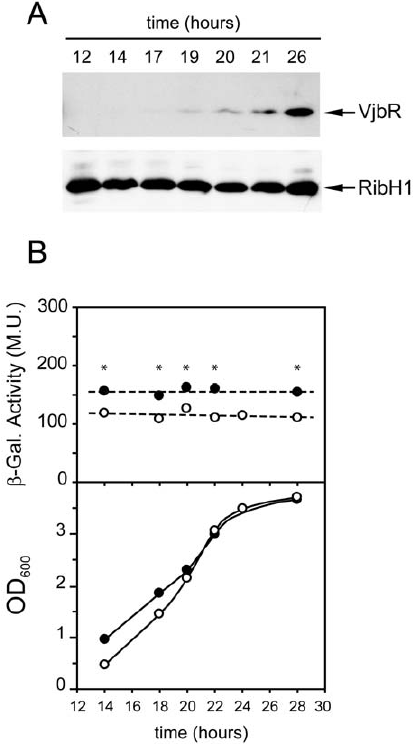
Figure 1. Analysis of expression of VjbR under standard culture conditions. (A) Western blot analysis. B. abortus 2308 wild type strain was grown in rich medium (TSB). At different times, optical density at 600 nm (OD 600 ) was determined, and samples were subjected to 10% SDS-PAGE, transferred to PVDF membranes, and developed with anti- VjbR or anti-RibH1 polyclonal antibodies. The corresponding optical density at 600 nm (OD 600 ) of each sample was 0.5, 0.7, 1.7, 2.6, 2.95, 3.5, and 3.6, respectively. Results from a representative of two independent experiments are shown. (B) Analysis of the vjbR promoter activity. Strains B. abortus P vjbR - lacZ (white circles) or B. abortus D vjbR P vjbR - lacZ (black circles) were cultured in TSB. OD 600 and b -galactosidase activities were determined along the growth curve at the indicated times. Values are means 6 standard deviations of duplicate samples from a representative of two independent experiments. Dotted lines indicate the best linear fit to the data. *, P , 0.05.